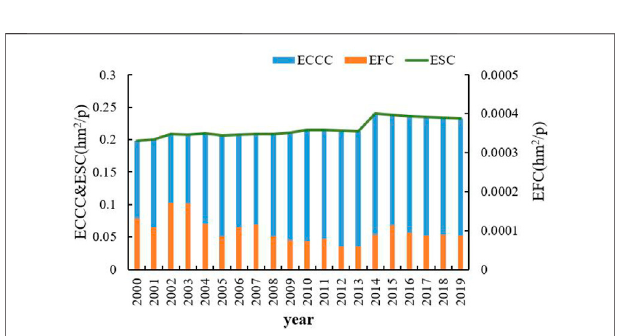
FIGURE 5 | 2000 – 2019 ECCC, EFC, and ESC of forest land in Sichuan Province.